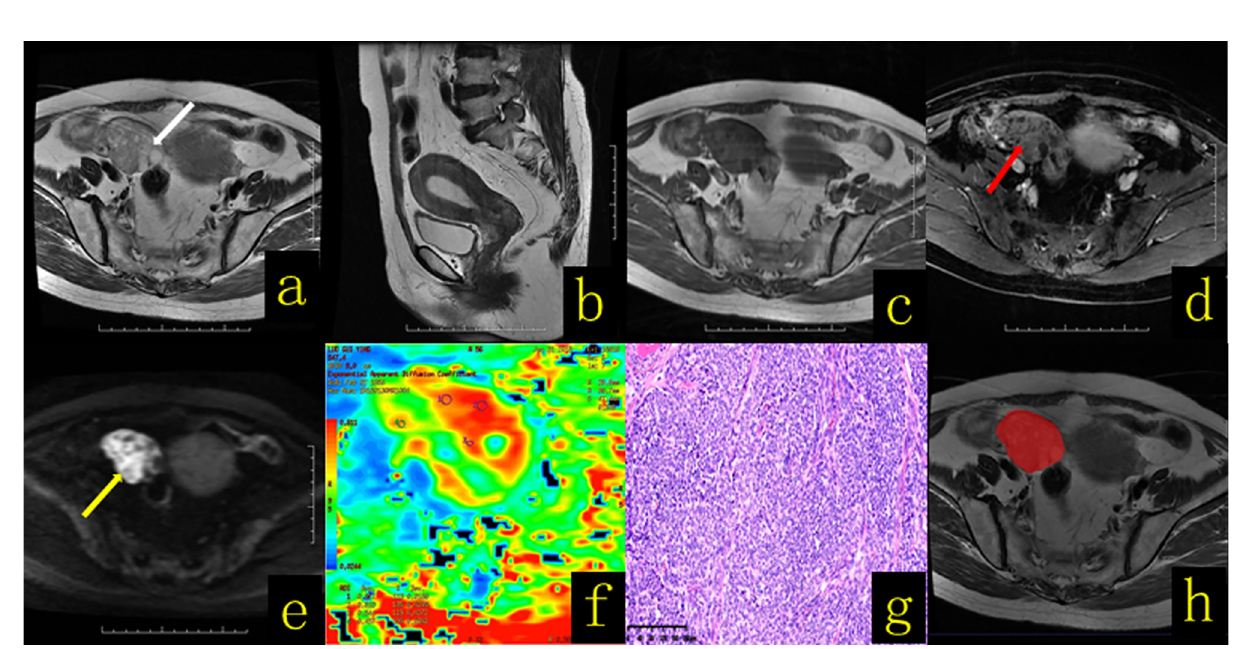
FIGURE 1 | A 61-year-old female patient with an ovarian granulosa cell tumor. (A) Axial T2WI revealed a cystic solid mass in the right adnexal region that manifested with a “ spongy ” or “ honeycomb ” change (white arrow). (B) Sagittal T2WI showed thickening of the endometrium to a thickness of approximately 1.9 cm. (C) Axial T1WI revealed a cystic solid mass with a hypo – isointense signal. (D) On contrast-enhanced fat-suppressed T1WI, the solid components (red arrow) of the lesion showed mild and moderate enhancement, with a region resembling the myometrium. (E) On DWI-MRI ( b = 1,000 s/mm 2 ), the solid part of the lesion appeared hyperintense (yellow arrow), and the cystic part appeared hypointense. (F) The apparent diffusion coef fi cient (ADC) map showed that the average ADC value of the diffuse high-signal area was approximately 0.7 × 10 -3 mm 2 /s. (G) Hematoxylin and eosin (H&E) staining (×100) showed that the tumor cells appeared as large islands, diffusely distributed in nests and rich in interstitial separation and blood vessels. (H) The texture analysis target area was delineated throughout the whole tumor layer by